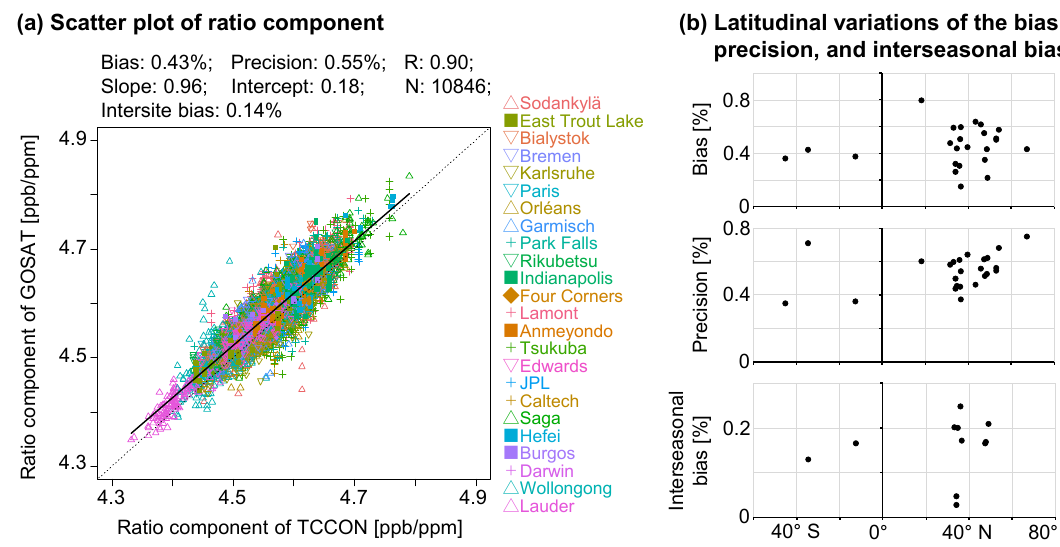
Figure 1. Comparison of the ratio component between Greenhouse gases Observing SATellite (GOSAT) and Total Carbon Column Observing Network (TCCON): ( a ) Scatter plot of individual data; ( b ) result for each site. GOSAT data obtained under conditions where cloud-free scenes were expected (cloud fraction = 0 and normalized 2 μ m band radiance ≤ 1) were used. In ( a ), the correlation coefficient (R), the slope and intercept of the linear regression, and the number of data points (N) are also shown. In ( b ), the latitudinal variations of the bias, precision, and interseasonal bias for TCCON sites having more than nine data points are presented.